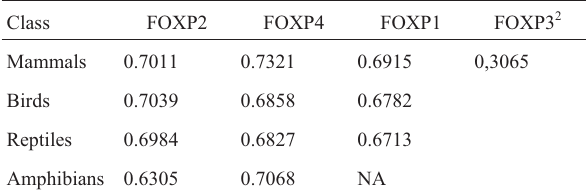
Table 1 - Mean disorder proportion for FOXP proteins by class 1